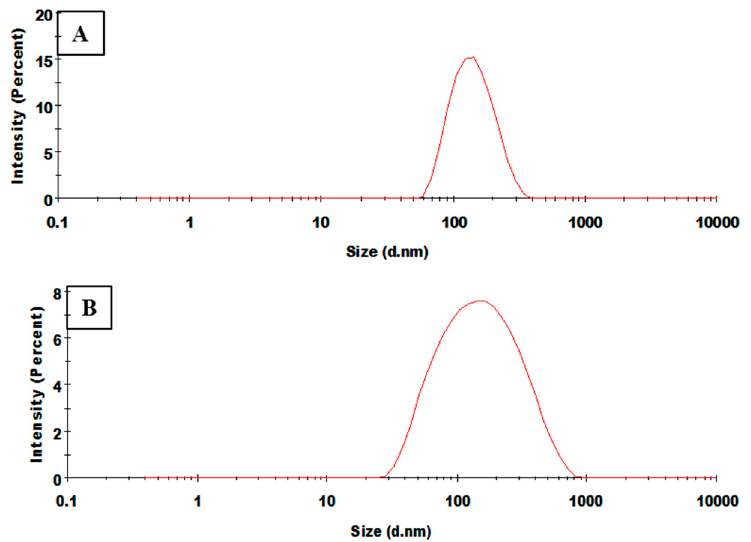
Figure 5. Represents DLS spectrum of ( A ) PGMD-DG 7:3, the particles size is 133.6 nm and ( B ) PGMD-DG 6:4 the particles size is 121.4 nm.